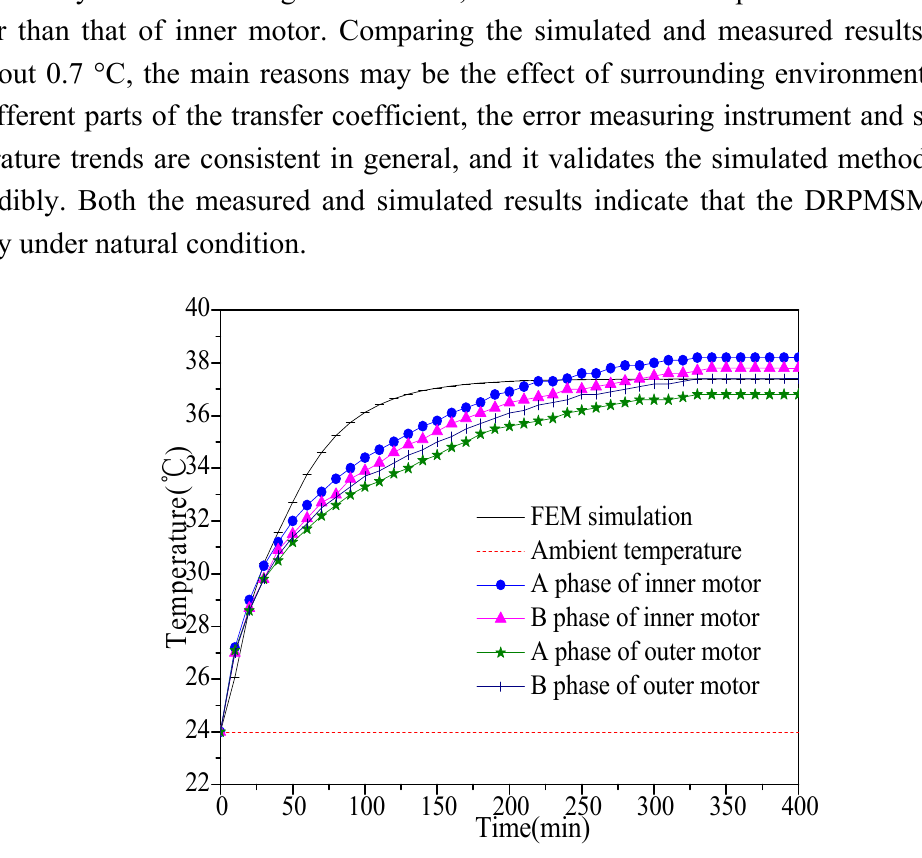
Figure 30. The measured and simulated temperature